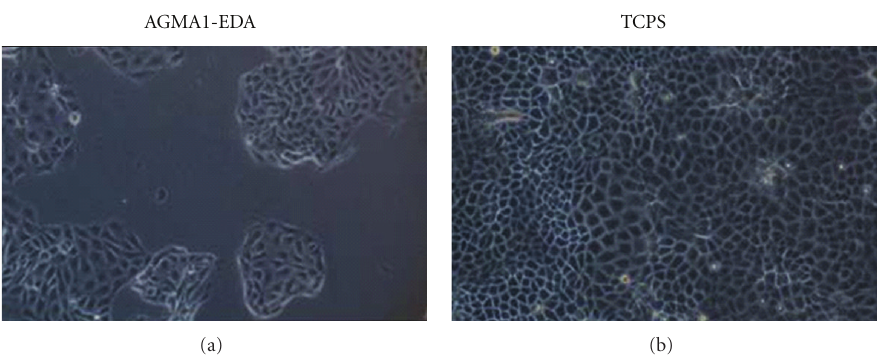
Figure 7: Optical microscopy images showing MDCK on TCPS and AGMA1-EDA at 72 hour after seeding